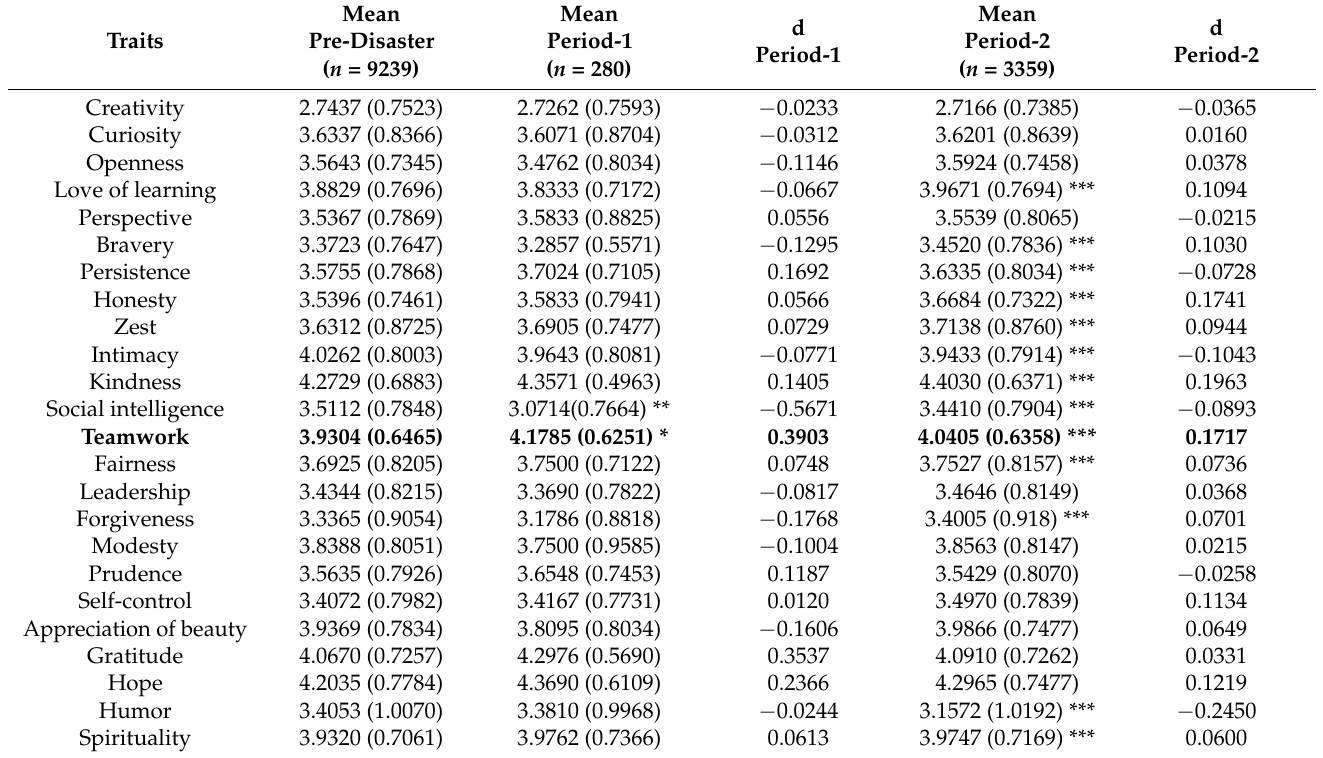
Table 4. Mean scores of the 24 character strengths compared before and during the